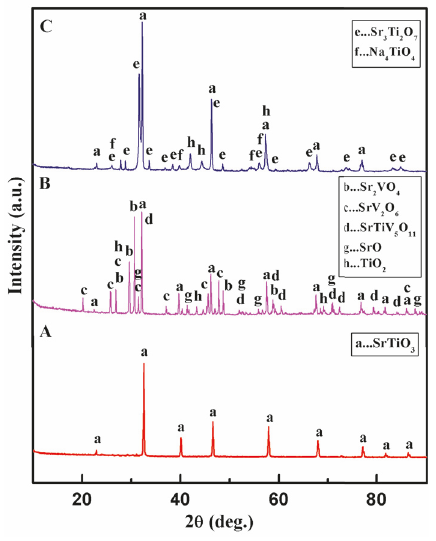
Figure 1: XRD patterns of the SrTiO 3 , (A) before exposure to hot corrosion and after exposure to hot corrosion at 900 ∘ C in (B) Na 2 SO 4 + 50 wt.% V 2 O 5 environment and (C) Na 2 SO 4 + 10wt.% NaCl